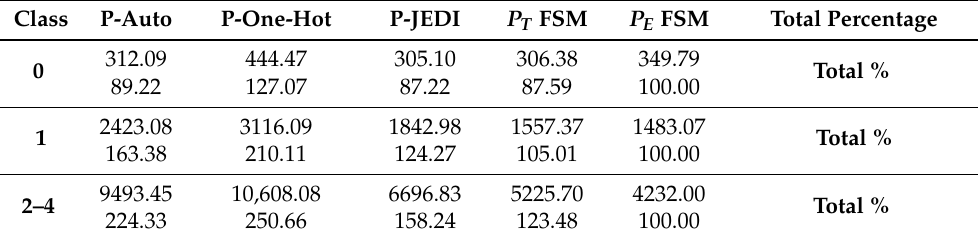
Table 12. Summarized results for FSM classes (products of LUT counts by propagation times).